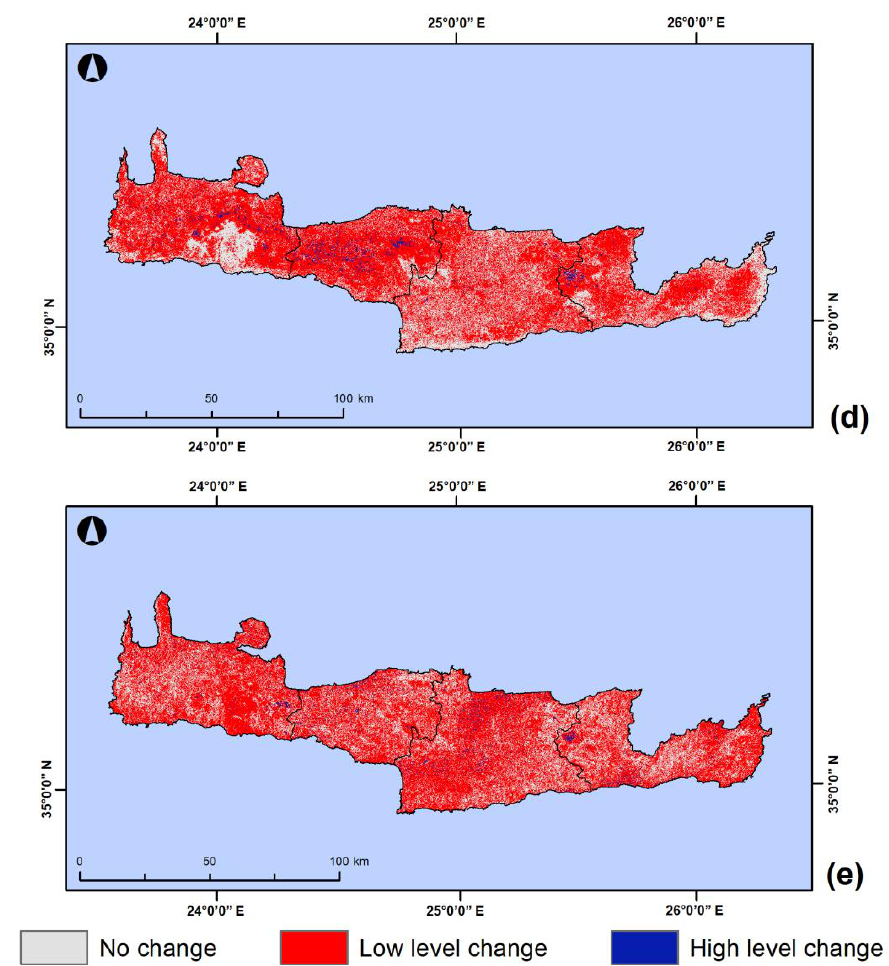
Figure 4. Change magnitude maps for the period of 1999–2009 from different index combinations: ( a )